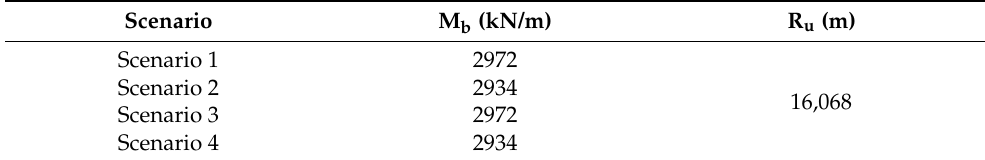
Table 9. Number of cases valid for formula validity parameters.